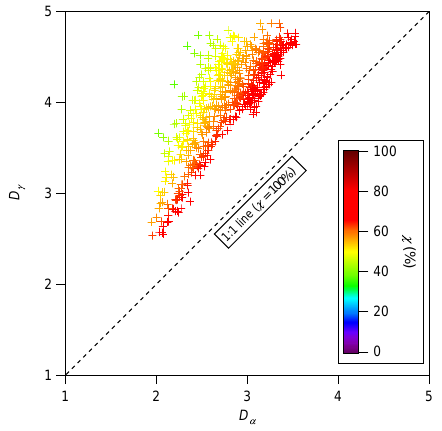
Figure 5. Mixing state diagram demonstrating the relationship be- tween average single particle diversity ( D α ) , bulk aerosol diversity ( D γ ) and mixing state ( χ) for each hour of the measurement period.